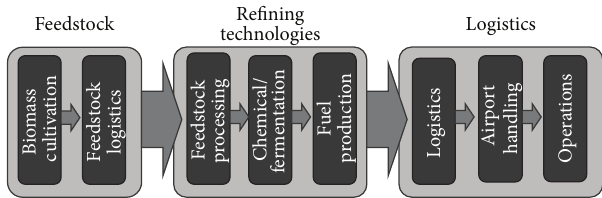
Figure 3: Roadmap components for biofuels in the aviation indus-